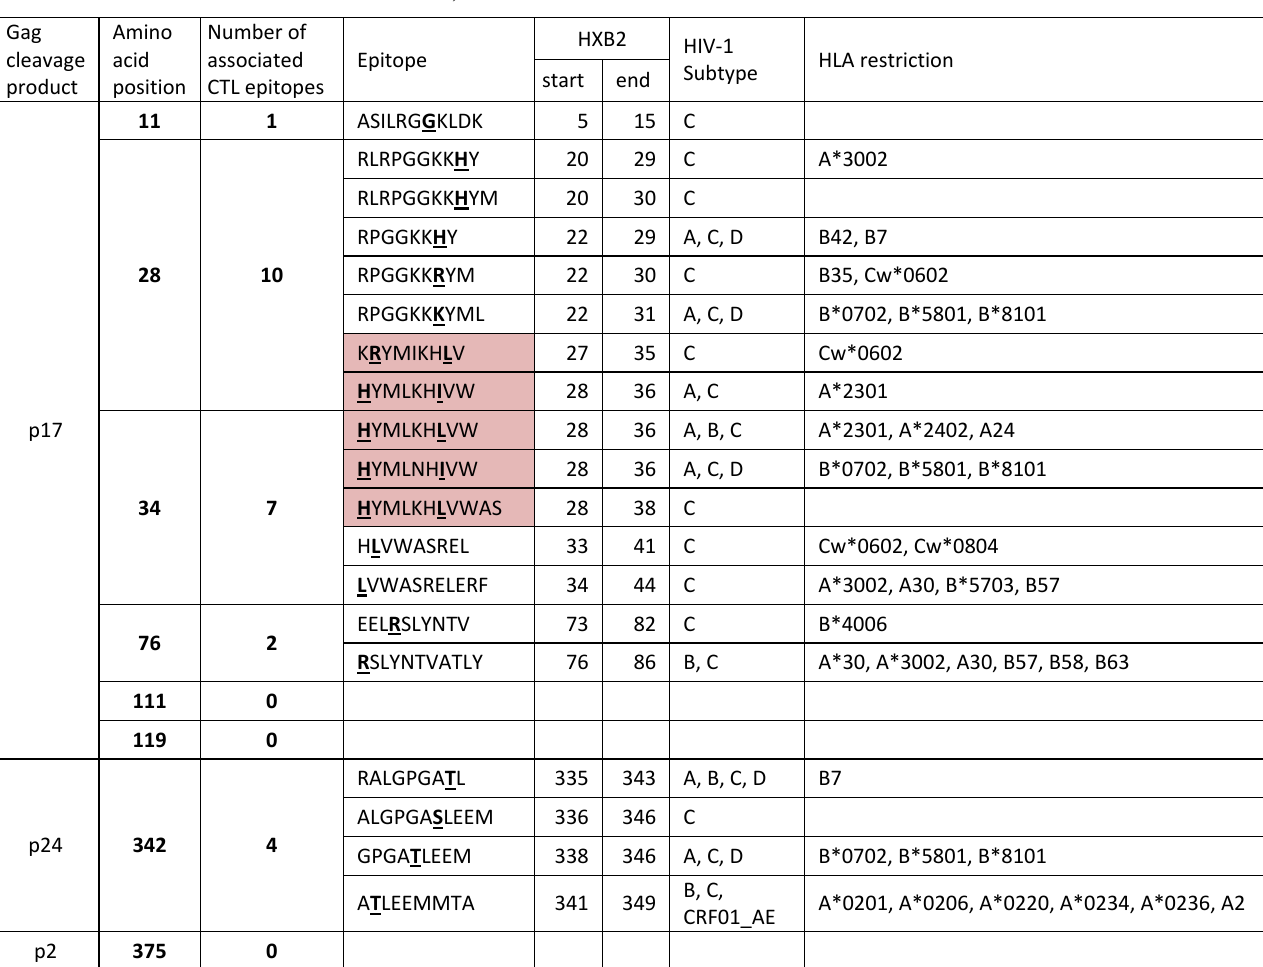
Table 1. Amino acid positions in HIV-1 subtype C Gag with frequency change ≥ 20% in the subtype C consensus sequence: potential association with known CTL epitopes. (Note: Epitopes with multiple changing amino acids are highlighted; changing amino acids are shown in bold and